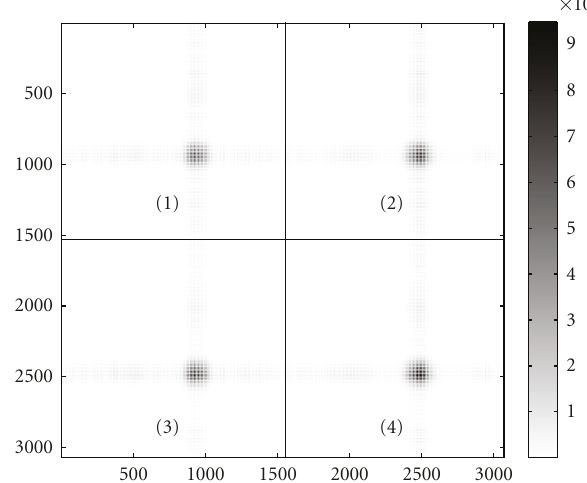
, block 4 is Figure 9: Modulus of the multicomponent wideband spectral XX , Γ , respectively. matrix of the second extracted wave Γ XZ ZX